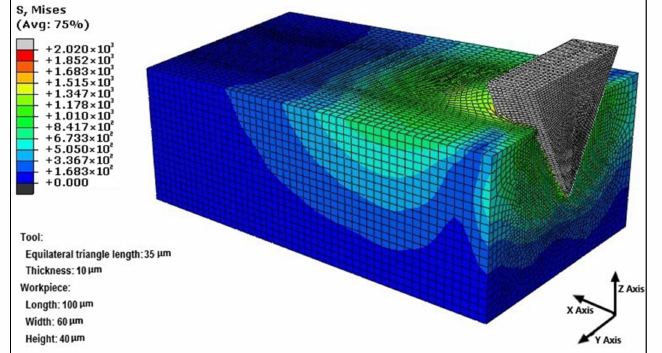
Figure 15. FE simulation model for the scratch experiment of AlFeSi